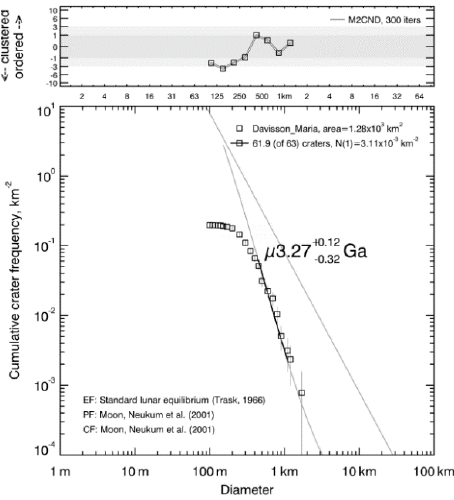
Figure 8. Dating results for basalt unit mapped in Figure 7. The equilibrium function is the standard lunar equilibrium of [35], while both the production and chronology functions are from [36].